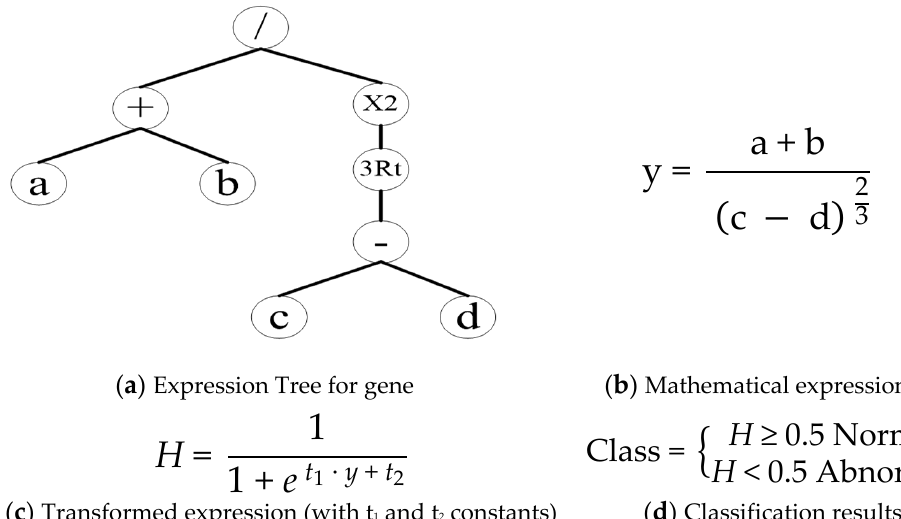
Figure 4. An example of the GEP model: ( a ) expression tree (ET), ( b ) the matching mathematical expression, ( c ) the transformed expression (H) using the sigmoid function, and ( d ) classification limits and categories. Note: a, b, c, and d are the feature variables of the processed model, while t 1 and t 2 are constants of the sigmoid function for developing the transformed expression (the related values after having implemented the mathematical model to the specific case are specified in Equation (9)).